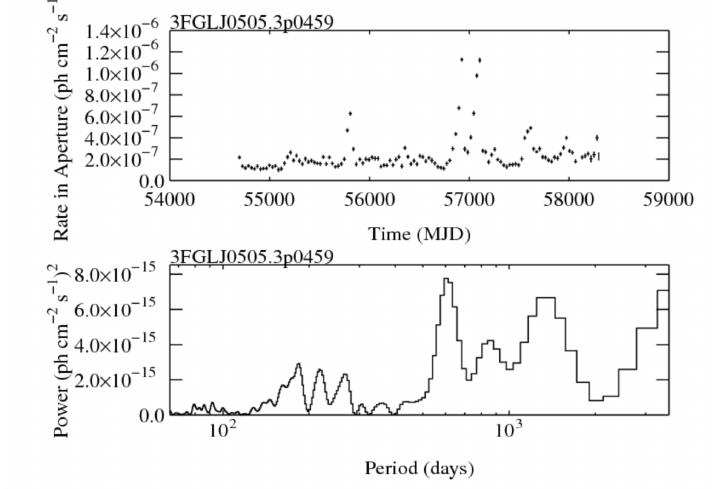
Figure 3. Fermi -LAT aperture photometry light curve and periodicity analysis for PKS 0502+049 as a function of MJD. The analysis shows no significant